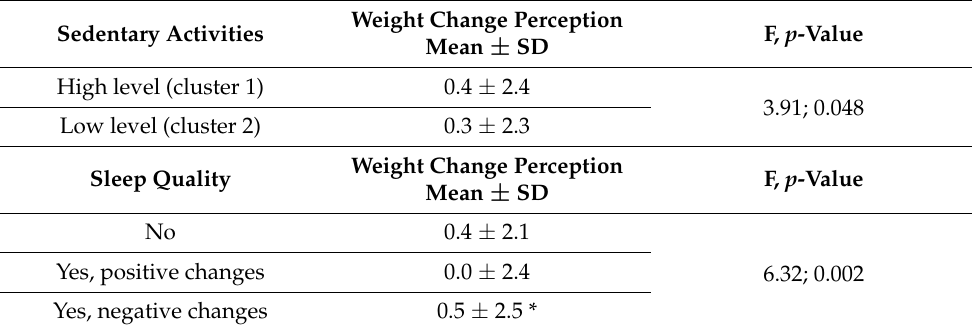
Table 3. Effects of sedentary activities during COVID-19 lockdown and sleep quality on weight change